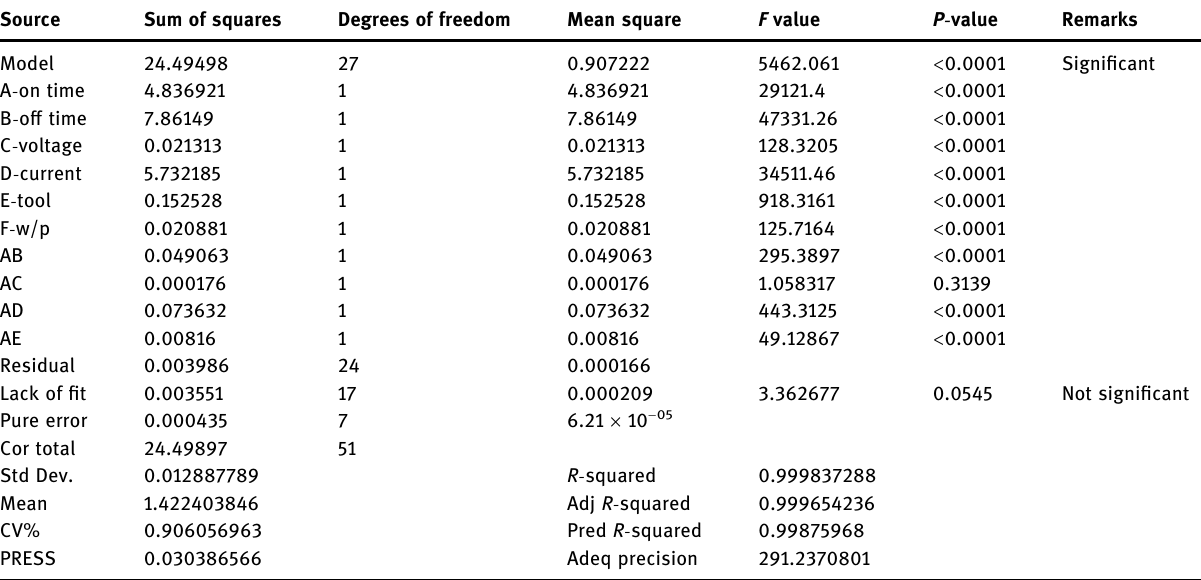
Table 4: ANOVA for response surface of